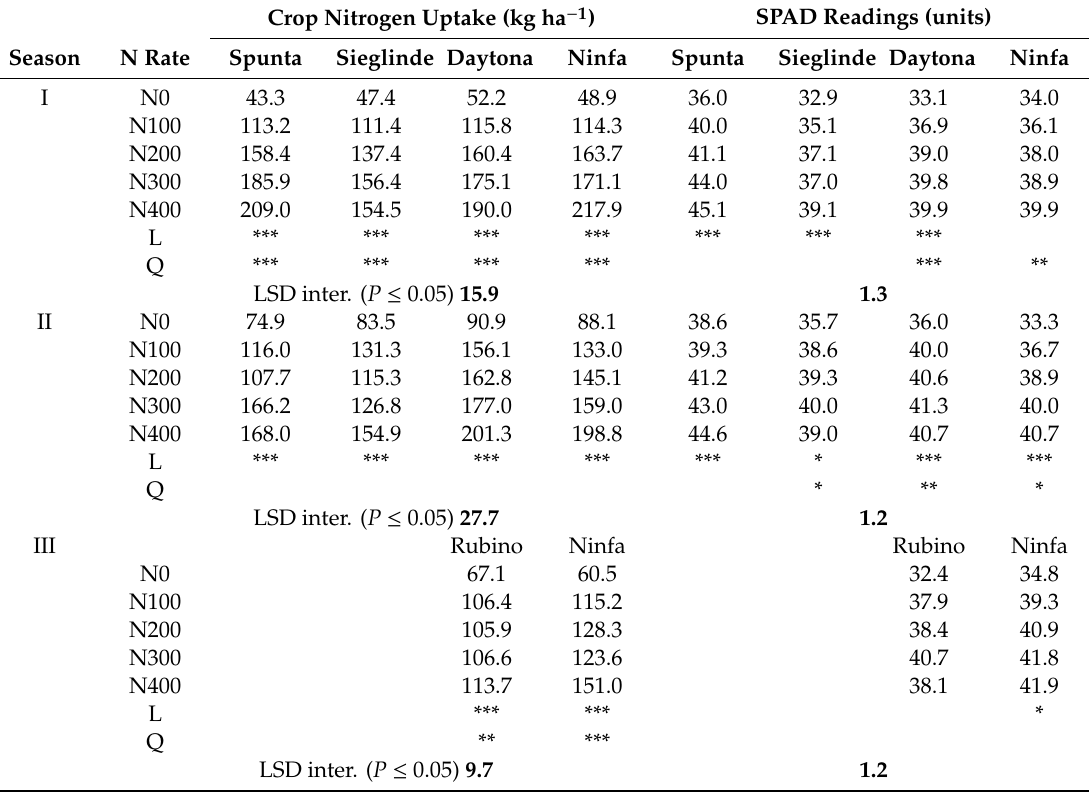
Table 2. Crop nitrogen uptake and SPAD readings as affected by “nitrogen rate x cultivar” interaction in the three seasons. Relationship tested by regression analysis, between N rate and responses of each variable and cultivar (L = linear, Q = quadratic; *, **, *** indicate significance at P ≤ 0.05; P < 0.01; P ≤